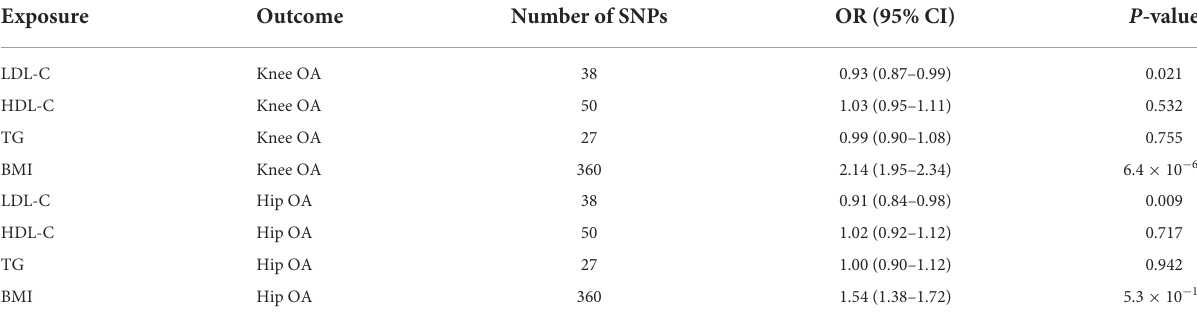
TABLE 2 Multivariate Mendelian randomization analysis results.